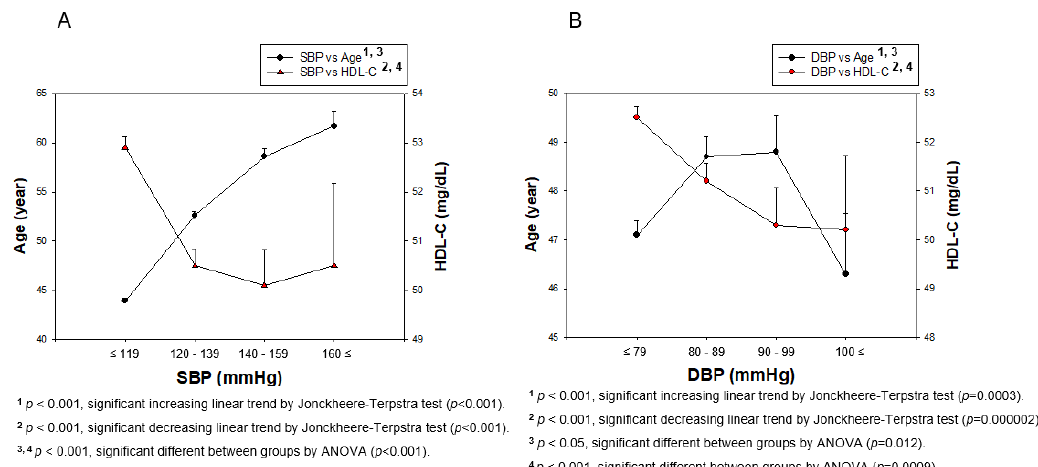
Figure 2. Correlation of age and HDL-C depends on SBP ( A ) and DBP ( B ) in total population. Negative association was found between age and HDL-C depends on SBP or DBP by J-T test. Pearson’s correlation analysis was carried out between age, HDL-C, and SBP ( A ) and DBP ( B ). Panel A showed positive correlation (r = 0.360, p < 0.001) between SBP and age; panel B showed positive correlation (r = 0.049, p = 0.0009) between DBP and age. In addition, panel A showed negative correlation (r = − 0.116, p < 0.001) between SBP and HDL-C; panel B showed a negative correlation (r = − 0.079, p < 0.001) between DBP and HDL-C.